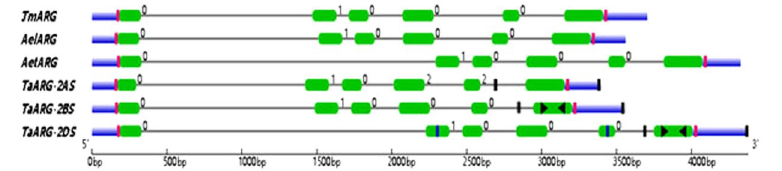
Figure 2. Structure of ARG genes in common wheat and wild diploid species. Tm, Ael, Aet, and Ta indicate Triticum monococcum , Aegilops longissima , Aegilops tauschii , and Triticum aestivum , respectively. Black lines represent introns, green rectangles represent exons, and blue rectangles represent UTRs. The columns mark the primer pairs used for the isolation of full-length TaARG genes (red), amplification of probe sequence for the southern blotting assay (yellow), and determination of chromosomal location (black). Primer pairs used for qRT-PCR analysis are indicated by horizontal triangles pointing in opposite directions. The number on the top left of the intron denotes intron